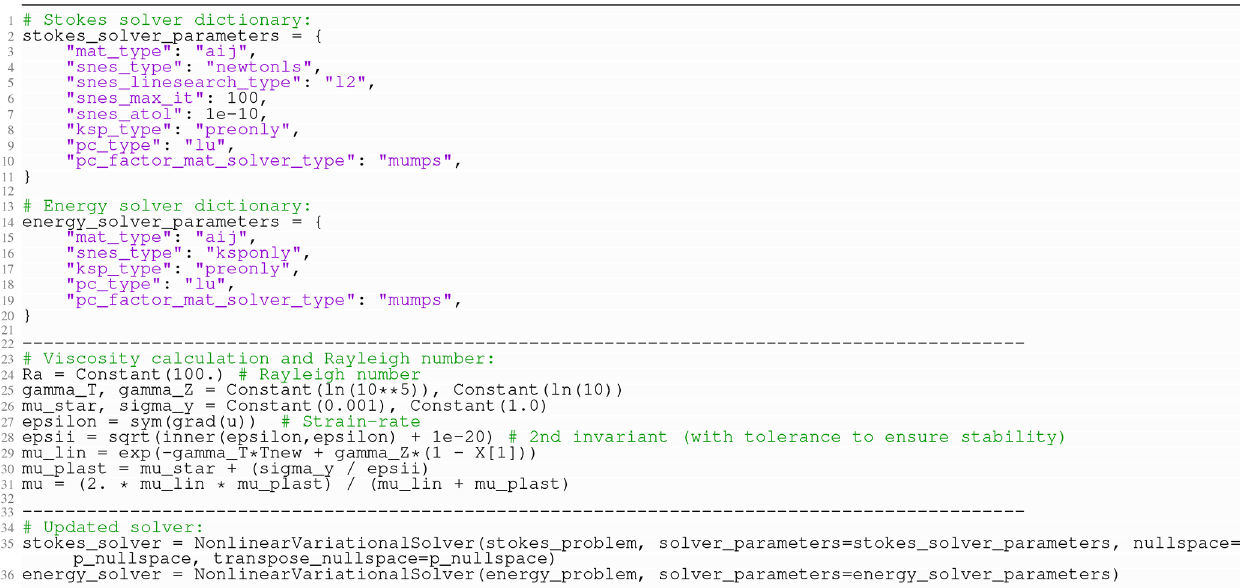
the second term in Eq. (38) represents the second invariant of the strain-rate tensor. The viscoplastic flow law (Eq. 36) leads to linear viscous deformation at low stresses and plastic deformation at stresses that exceed σ y , with the decrease in viscosity limited by the choice of µ (cid:63)